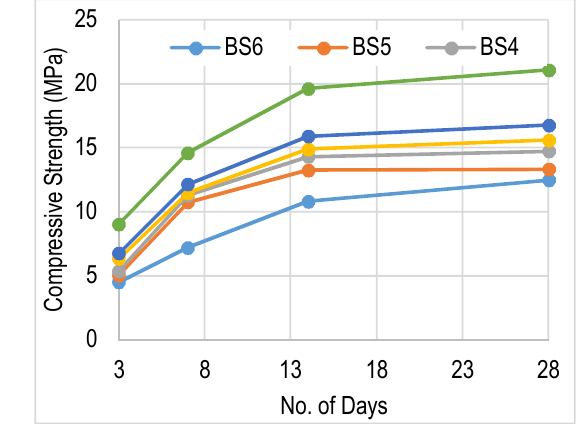
Fig. 7: Compressive strength of concrete cube specimens with 0%-1% MC content (1 MPa = 145.04 psi))